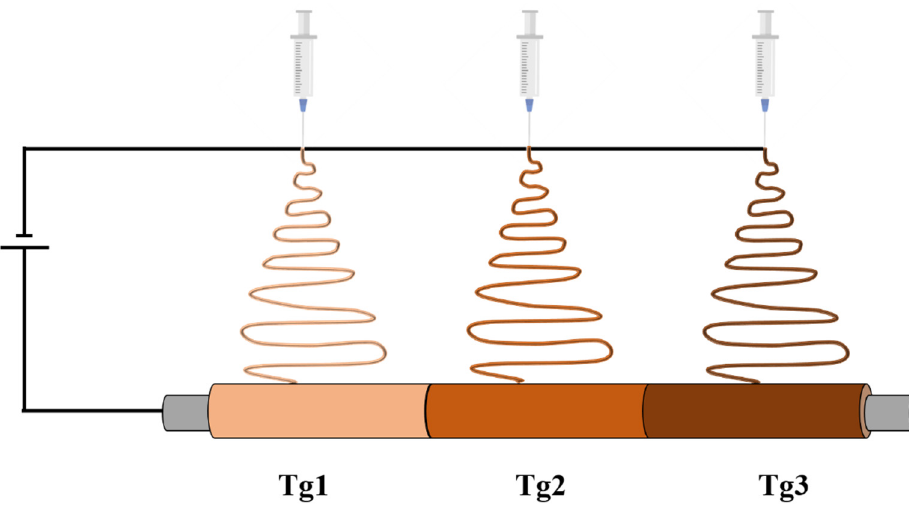
Figure 14. Representation of the fabrication of the trisegment SMP by electrospinning.